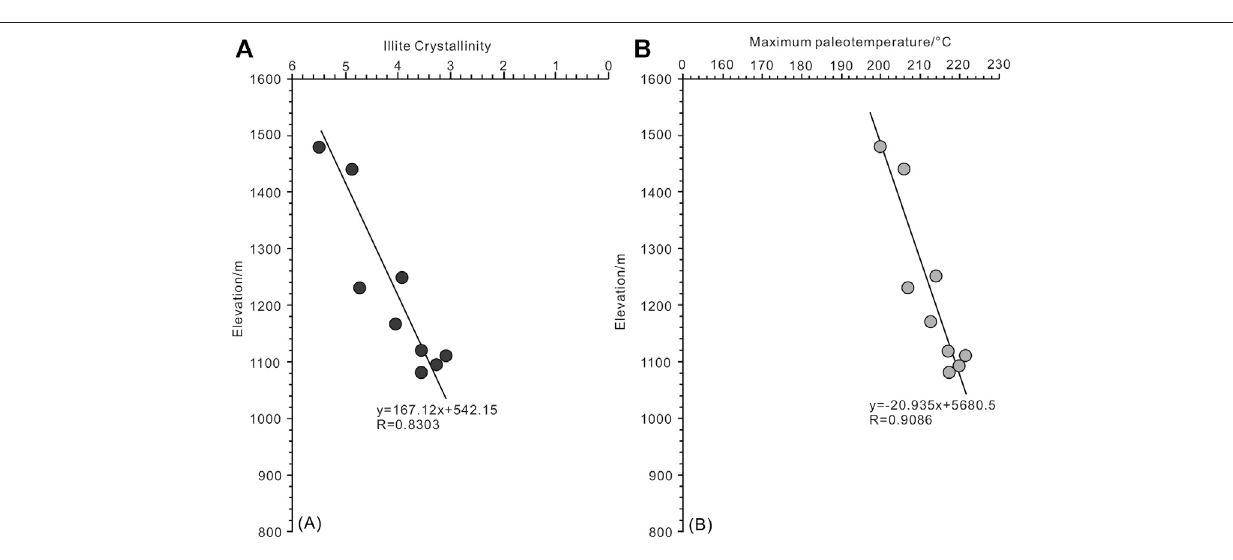
Frontiers in Earth Science |